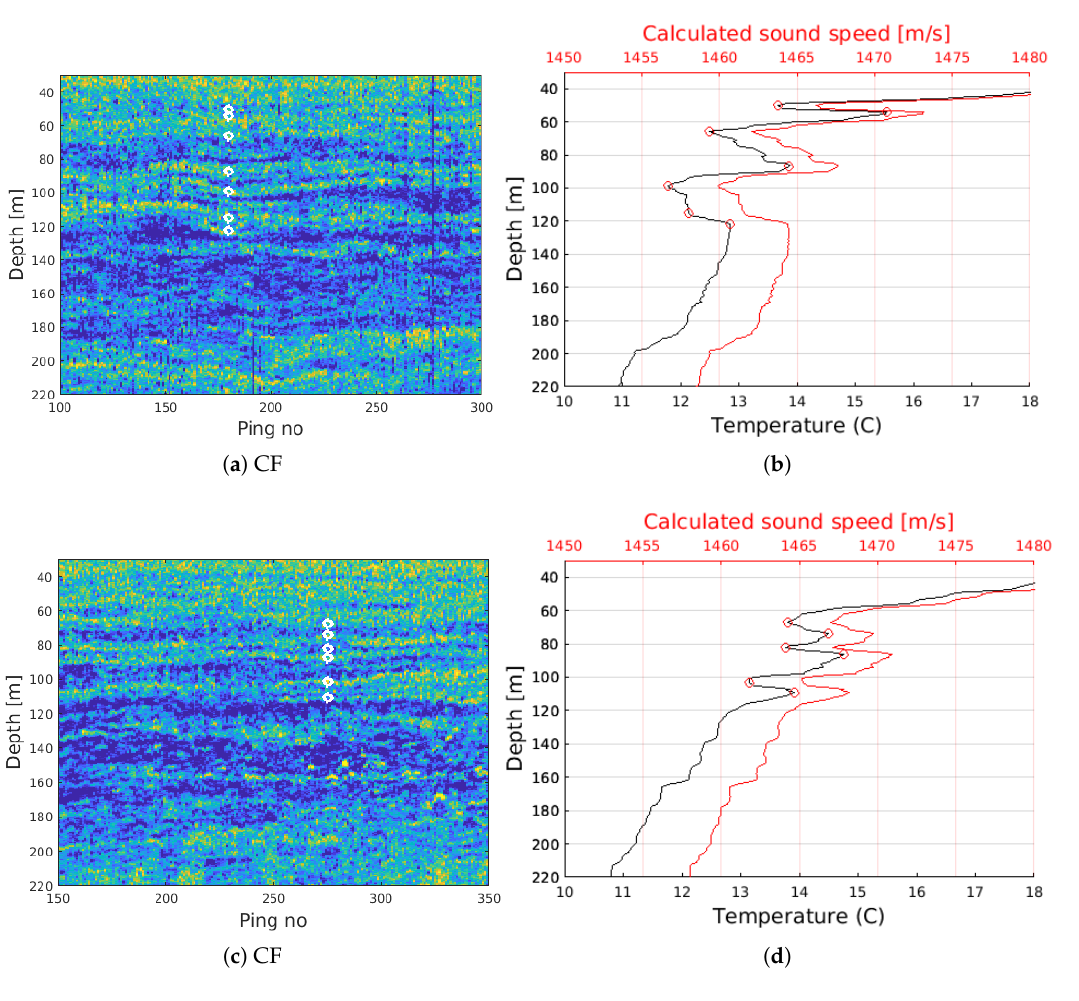
Figure 5. Analysis of regions of interest from Figure 3d ( a , b ) and Figure 3f ( c , d ) show good correspondence between the horizontal scattering layers observed in the CF imagery, and sharp temperature and velocity gradients derived from CTD casts. The white circles in the CF images correspond to sharp velocity gradients manually observed in the temperature depth profiles (indicated by red circles). The CTD data were acquired within 60 m of the SBES lines, and with a time offset of three hours ( a , b ), and 30 h ( c , d ). The time delay between acquisition of the SBES lines and the CTD casts allows for vertical movement and disbursement of the organisms within the scattering